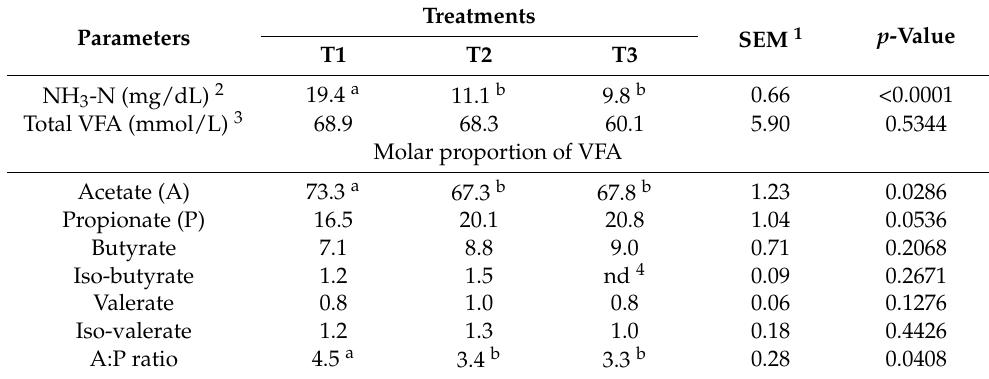
Table 2. Effects of supplementing barley sprouts on the ruminal fermentation profile of meat-master lambs.